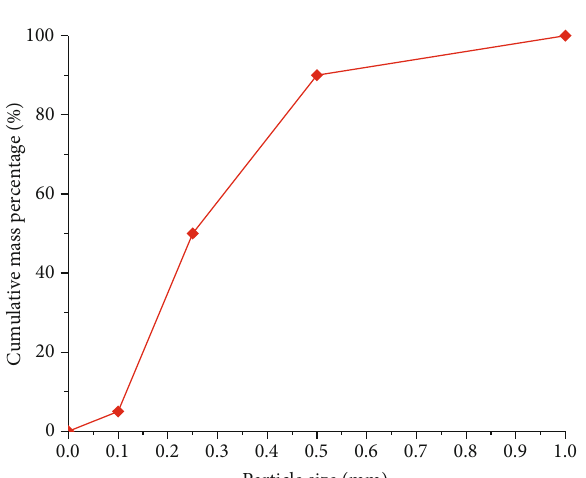
Figure 2: Experimental materials.